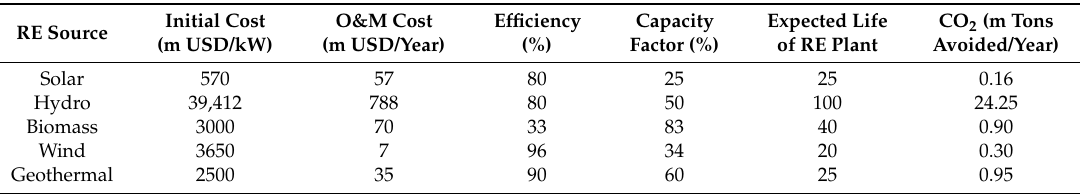
Table 5. RE data of various RE resources of Pakistan